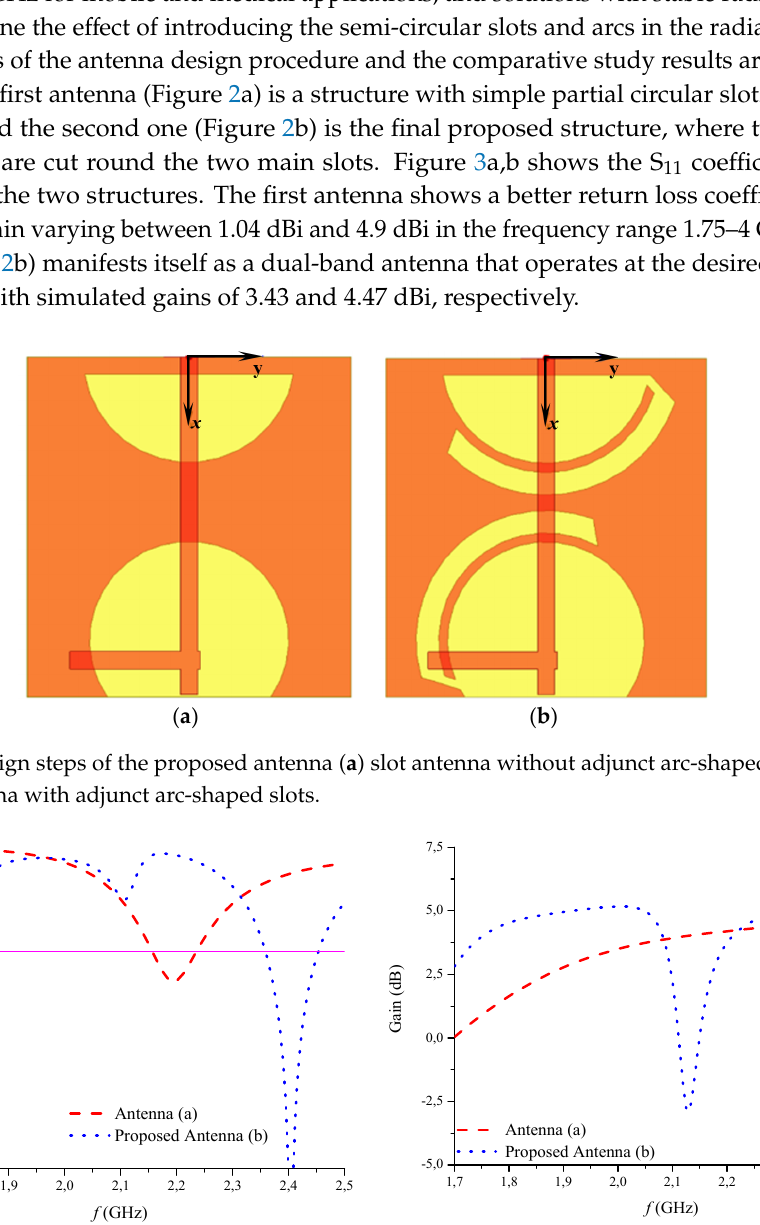
Figure 1. Design parameters of the proposed antenna, ( a ) overall optimized dimensions and ( b ) slots parameters.